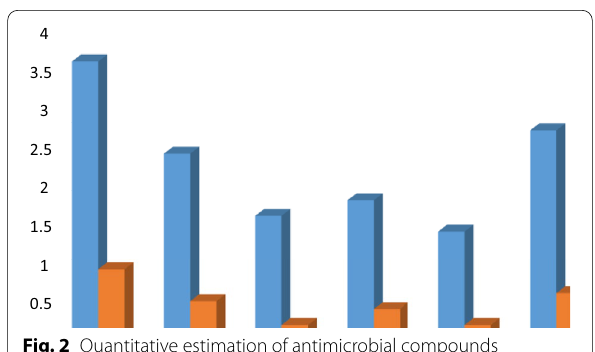
Fig. 2 Quantitative estimation of antimicrobial compounds produced by yeast isolates (lactic acid and diacetyl)